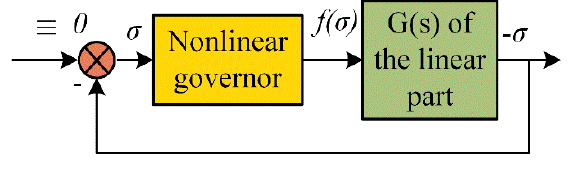
Figure 5. Nonlinear VSG-IIDG model.